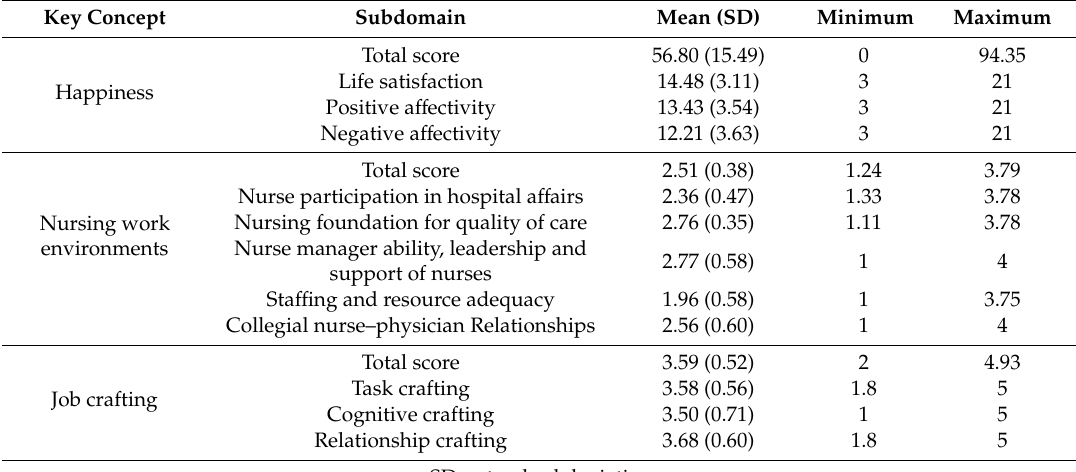
Table 2. Descriptive findings of key variables.